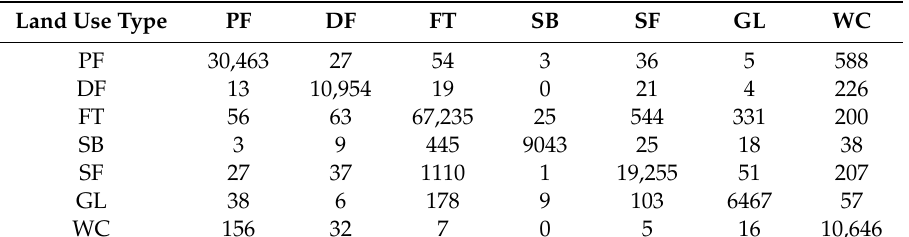
Figure 4. Spatial distribution of land use in ( a ) 2005 and ( b ) in 2015; ( c ) shows the change of land use between 2005 and 2015. Table 1. Transfer matrix of land-use change from 2005 to 2015 (unit: km 2 ).